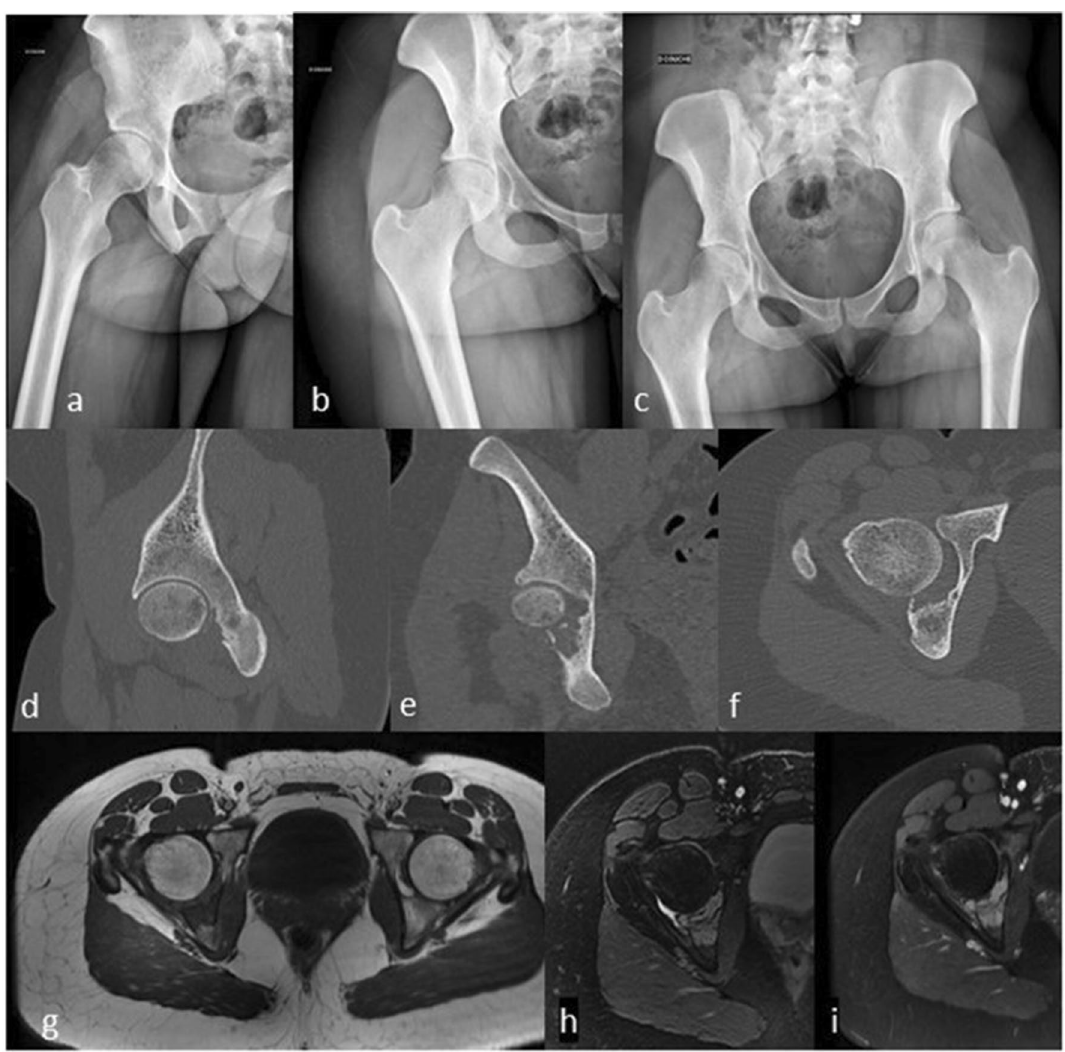
Figure 2. Case of Langerhans cell histiocytosis. A 24 years-old female, no smoker and no drinker has been experiencing left hip pain in the last 6 months relieved by Cortisone injection, with recurrence of the pain 4 months later. No general status loss was observed. There was an inflammatory syndrome on blood test. On palpation, pain was localized on the ischium and on the mobilization of the hip without sensitive or motor dysfunction. ( 1a/c ) Standard radiographs of the hip. ( 1d/f ) Sagittal, frontal, and axial views on computed tomography. ( 1g/i ) T1 and T2 axial and T1gado axial views on magnetic resonance